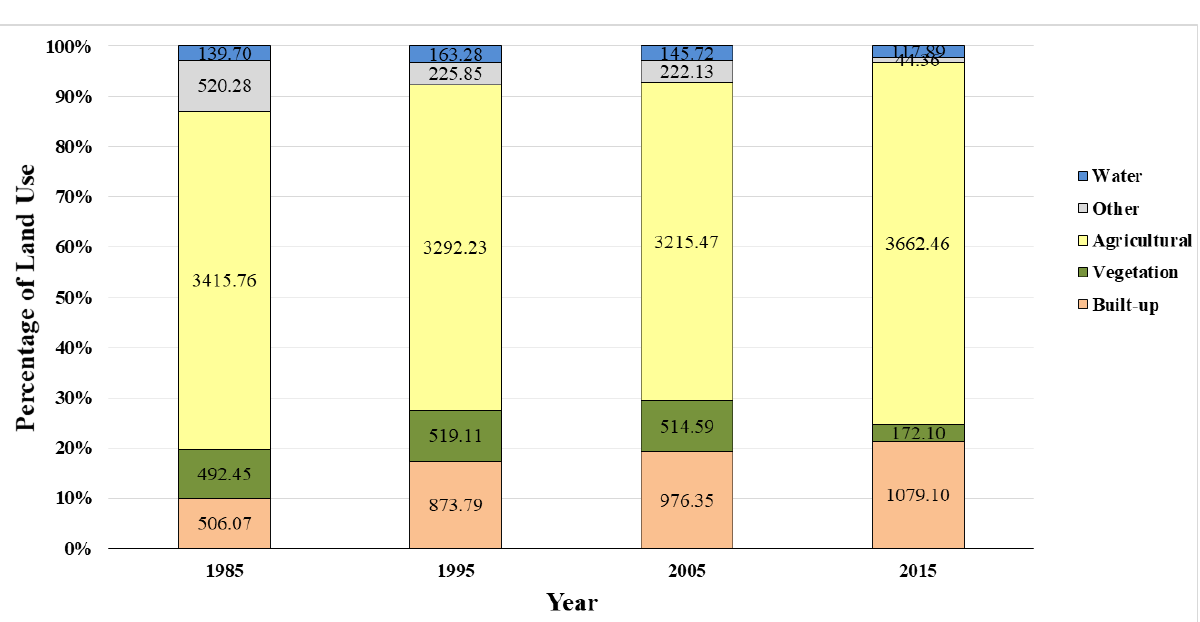
Table 2. Change Matrix for Land use classes in 11 smart cities of Uttar Pradesh for 1985 to 2015.